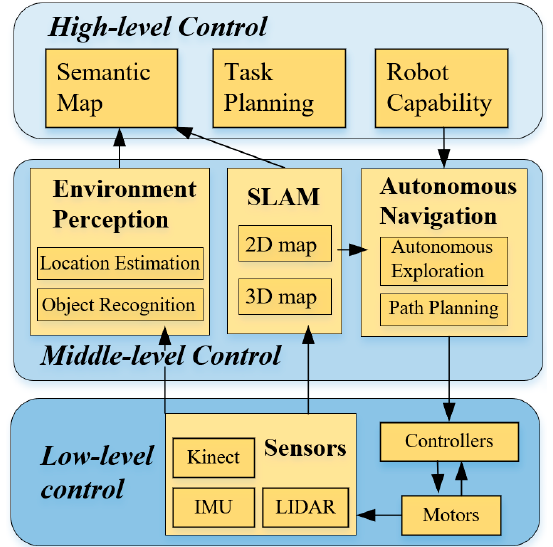
Figure 1. The three levels of robotic control defined in article.